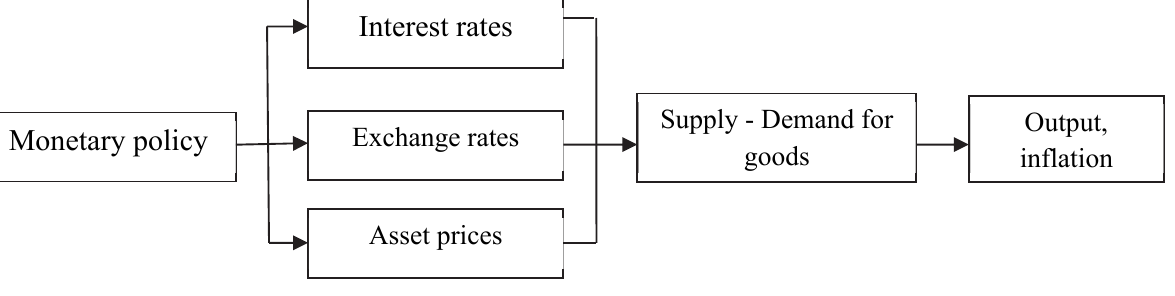
Fig. 2. The monetary transmission mechanism to economic of Mankiw